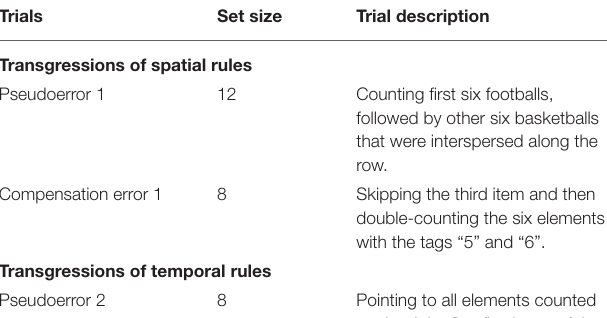
TABLE 2 | Description of the non-routine